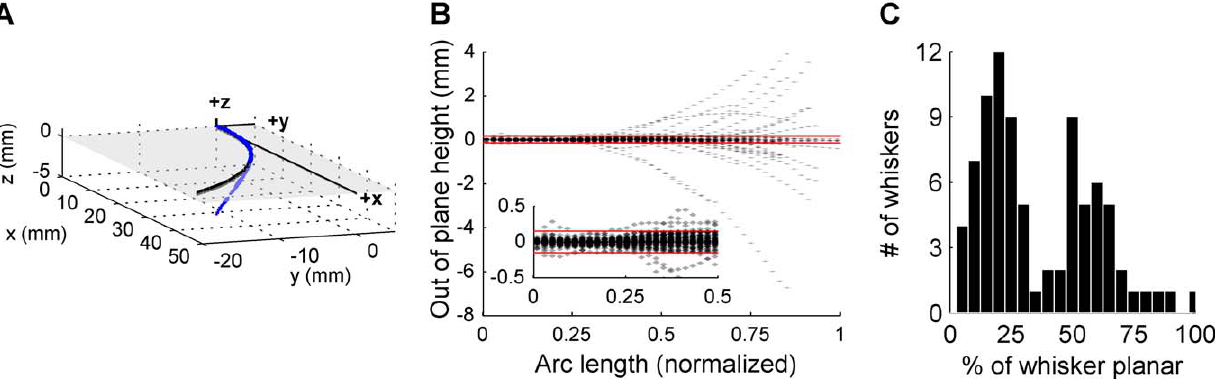
Figure 4. Out of plane curvature. ( A ) Comparison between the 3D scan (blue) and the 2D scan (black) for one whisker. The xy -plane is shaded and transparent to show 3D points above and below the plane. ( B ) Planar residuals for 84 whiskers. Individual whiskers are plotted in transparent gray, so that overlapping whisker points appear darker. Red lines indicate the planar threshold criteria of 6 150 microns. Note that the whisker lengths are normalized by the 2D whisker lengths. Thus not all 3D whiskers extend to one (100%) because the 3D laser scanner did not always capture the entire length of the whisker (see Materials and Methods). Inset: Zoomed-in region from 0% to 50% of the normalized whisker length. ( C ) Histogram of the number of whiskers at each planar percentage. Bin size is